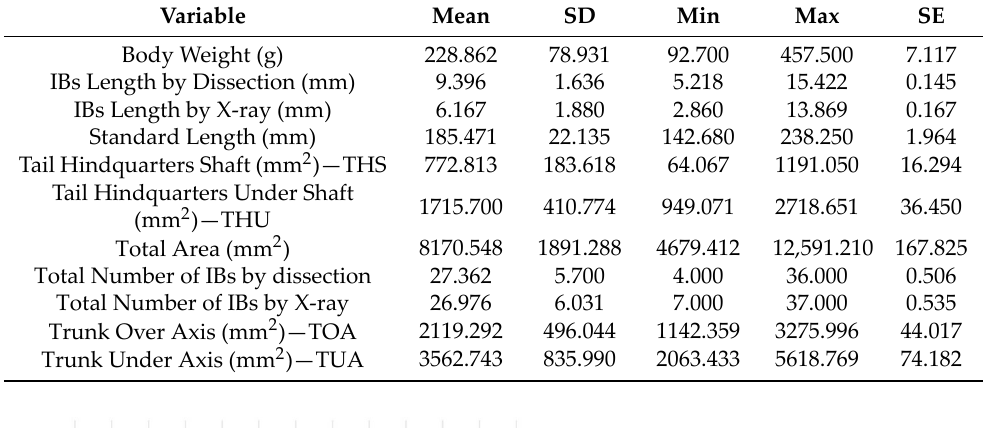
Table 2. Intermuscular bones variation assessed via X‑ray and dissection methods and standard length and body weight in tambaqui.